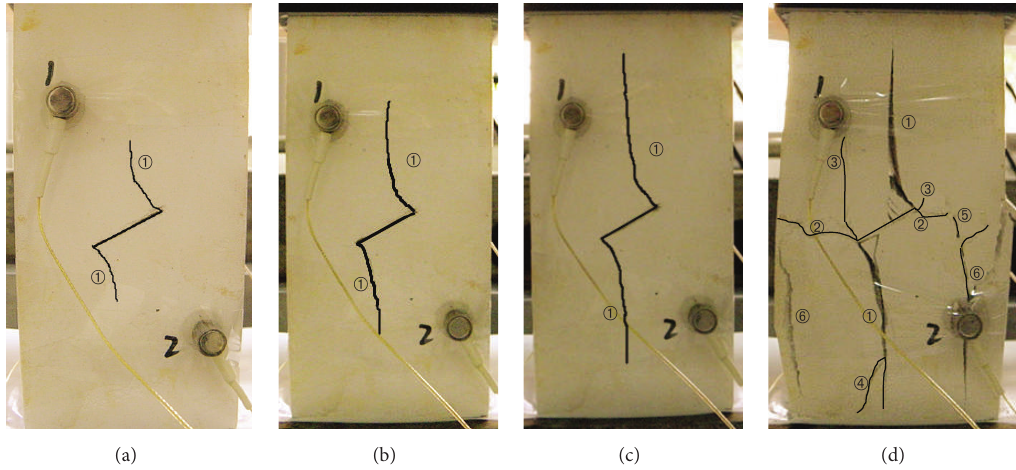
Figure 5: Fracture propagation process of specimen A. (a) 𝜎 1 = 2.45 MPa. (b) 𝜎 1 = 2.87 MPa. (c) 𝜎 1 = 3.33 MPa. (d)